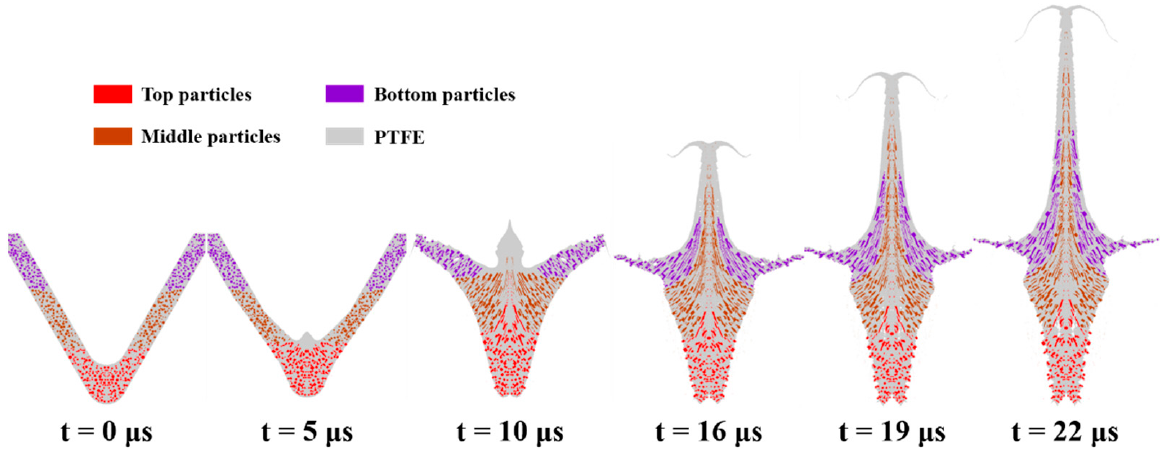
Figure 15. Typical uniform-distributed particles movement in the jet formation process. The mass fraction and velocity charts of the aluminum particles from different parts of the liner are shown in Figure 16. In Figure 16a, the jet formed by the liner with uniform distributed particles is divided into 10 parts, and the mass fractions of the particles from each part are shown as three curves, respectively. As a whole, the particles from three parts of the liner are distributed in sequence from the head to the slug. The bottom particles are mainly distributed in the top and middle area of the jet, and the top particles are mainly distributed in the slug. In HSSJ, most of the aluminum particles are from the bottom and the middle area of the liner, while the top particles can hardly enter the HSSJ. Figure 16b shows the velocity–time profile of the Al particles from three parts of the liner. The figure shows that, in the formation process, the top particles are first accelerated, and then quickly drop to a relatively low speed. The middle and bottom particles are subsequently accelerated to a higher speed. At the same time, both the curves of the middle and the top particles contain a deceleration period. That is because when the wall of the liner collapses and closes, pressure is transferred from the back forward to the particles closer to the axis, and forcing them into the area with higher velocity. As a result, the particles from other